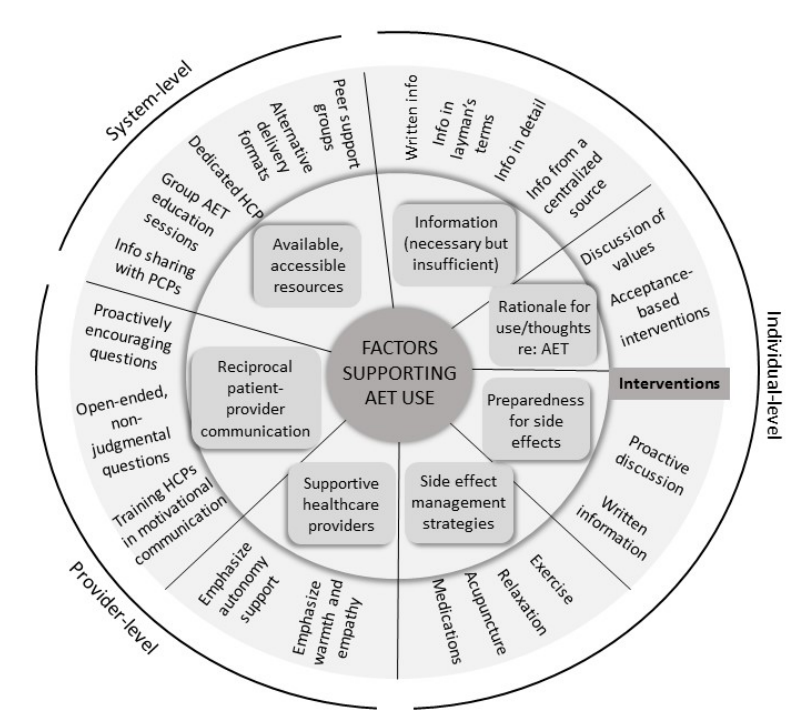
Figure 1. Factors supporting adjuvant endocrine therapy use and potential interventions. Factors are based on interviews with women who persisted, women who discontinued, and healthcare providers. Potential behavioural intervention com- ponents worth investigation are mapped onto each factor. Interventions could occur at the individual-, provider-, or sys- tem-level. AET = adjuvant endocrine therapy, HCP = healthcare provider, PCP = primary care provider.